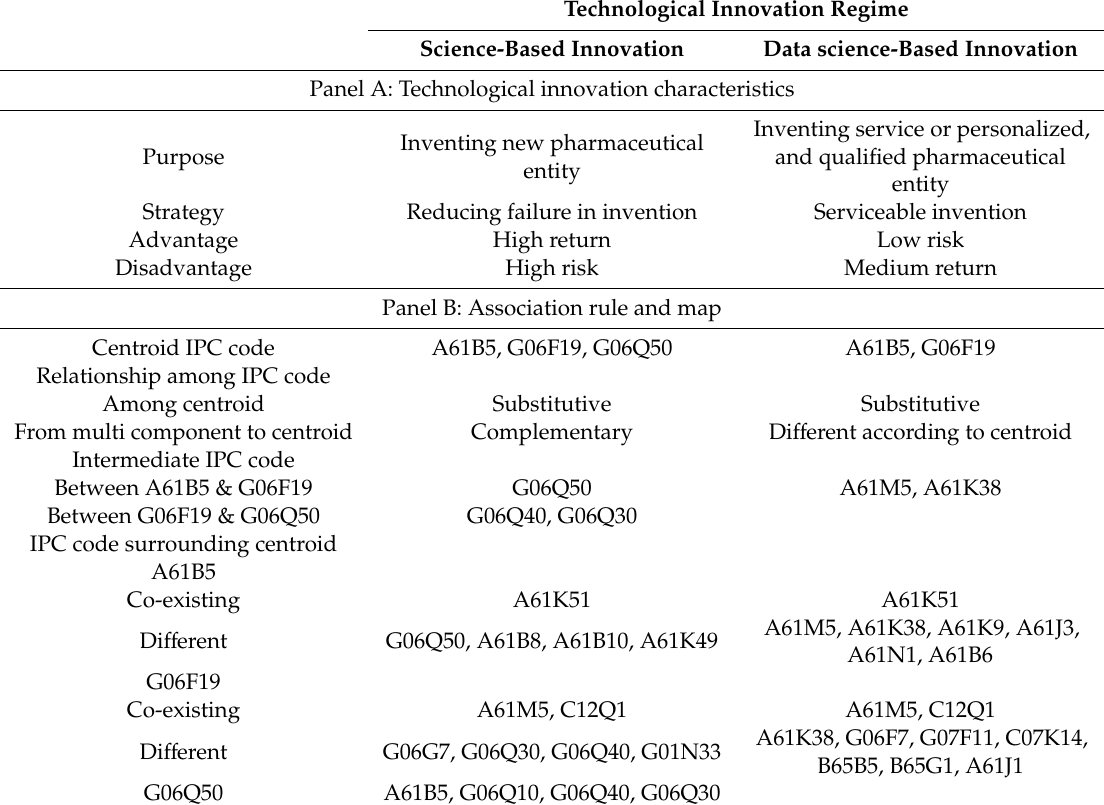
Table 7. Summary of di ff erences between science-based innovation and data science-based